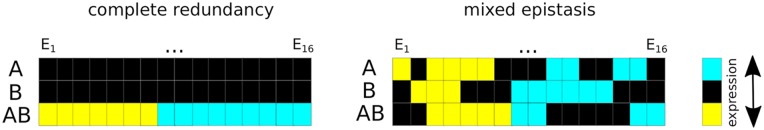
Schematic representation of different buffering relationships.Left: Complete redundancy is explained by an effect only being visible when both genes A and B are knocked out simultaneously. Right: Mixed epistasis is characterized by a mixed behaviour of two genes. Their interaction differs for different gene sets.